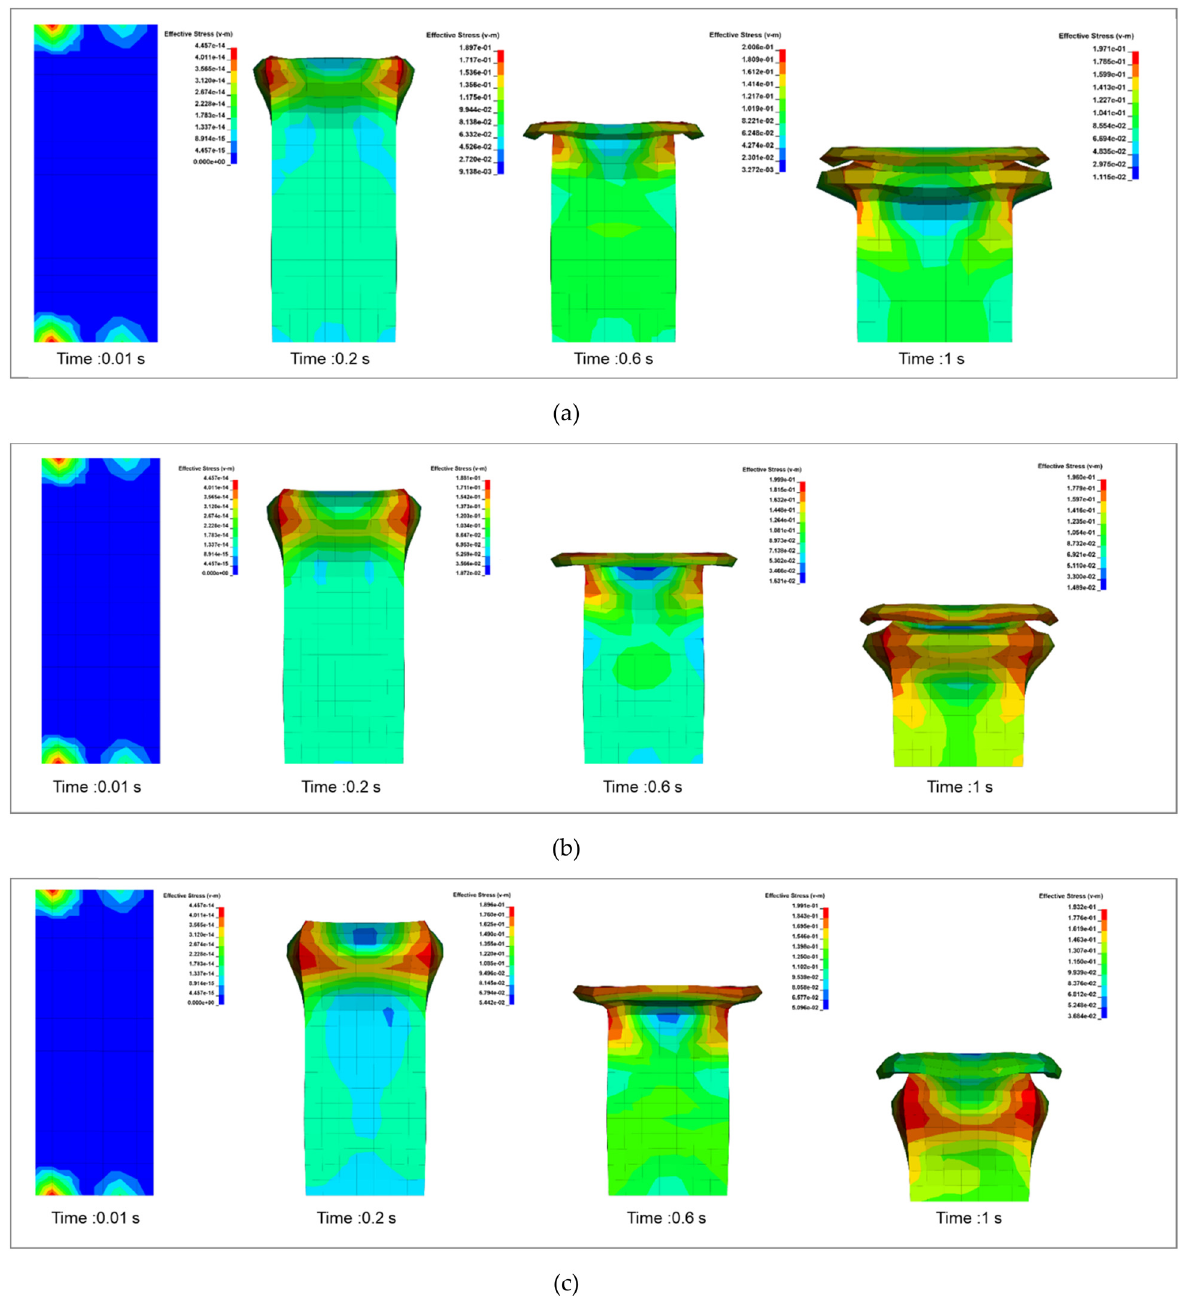
Figure 14: Distribution of the von - Mises stress on the specimen scaling the time from 0.01 to 1 s. ( a ) 2 mm wall thickness, ( b ) 3 mm wall thickness, and ( c ) 4 mm wall